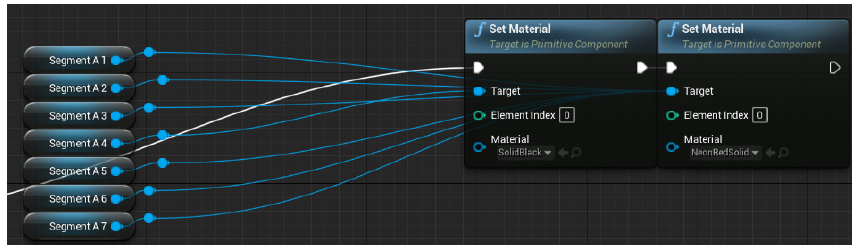
Figure 9. Seven-segments displays set